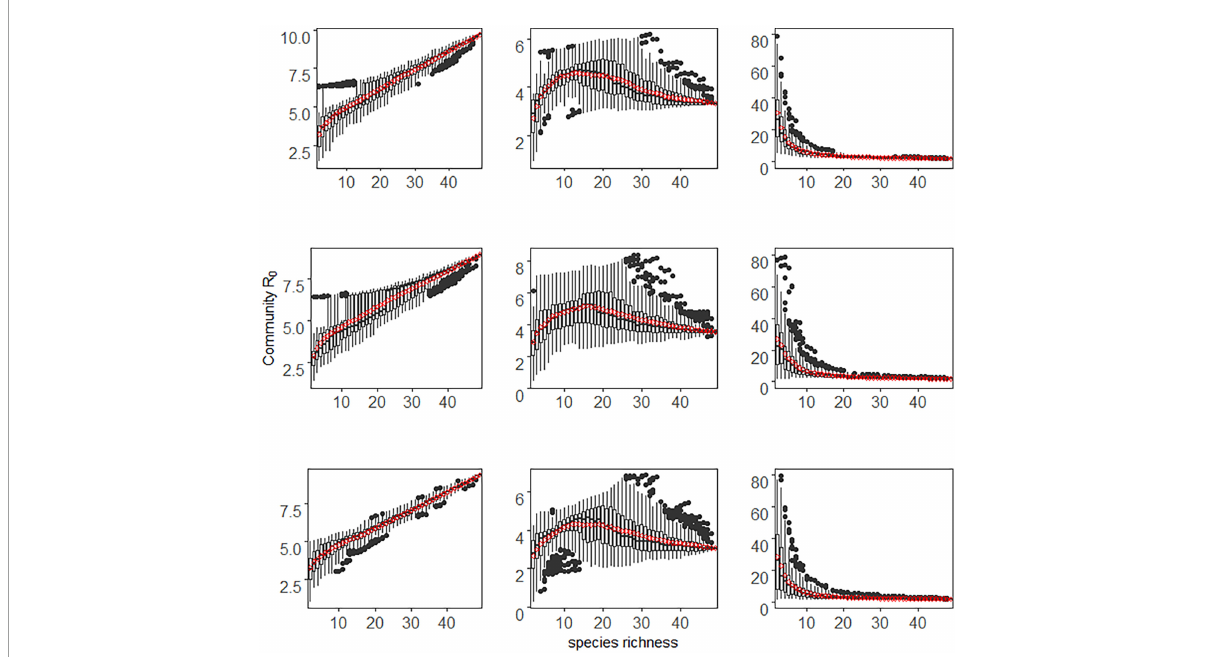
FIGURE1 The relationship between host species richness and community R 0 under density-dependent transmission and stochastic extinction scenario. Each column represents different community assembly pattern. From the first column to the third column are additive, saturated, and compensatory assembly, respectively. Each row represents the relationship between host competence and abundance. Positive, neutral, and negative correlations are from the first to the third row. The x-axis in each panel represents species richness, and the y-axis represents community R 0 . Each boxplot represents the values of 1,000 simulations for each species richness level, and the red dots represent the mean values of community R 0